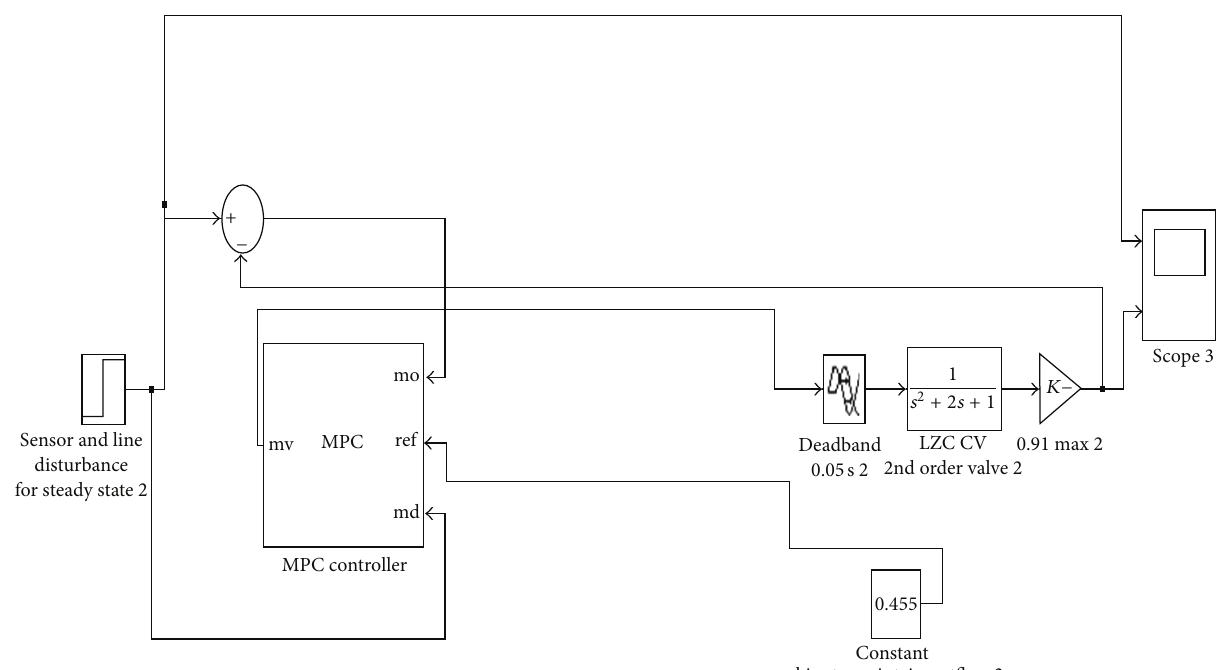
Figure 11: MPC for LZ controller set-up in